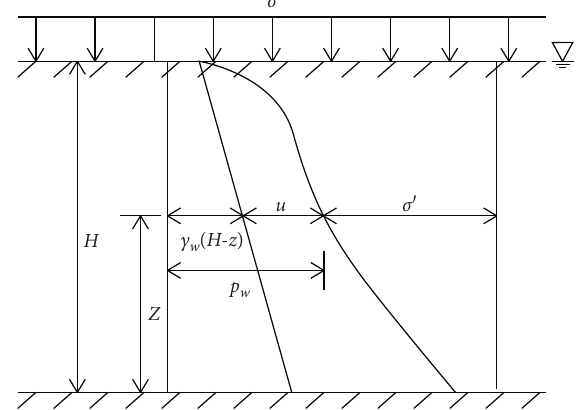
Figure 1: One-dimensional seepage consolidation model of sat- urated